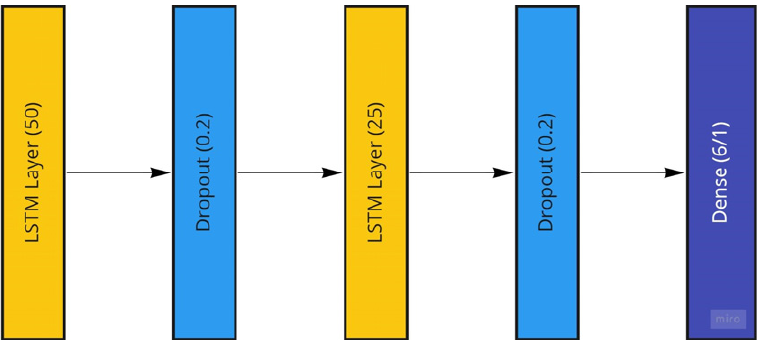
Figure 12. The Long Short-Term Memory Recurrent Neural Network Model utilized featuring two LSTM layers.